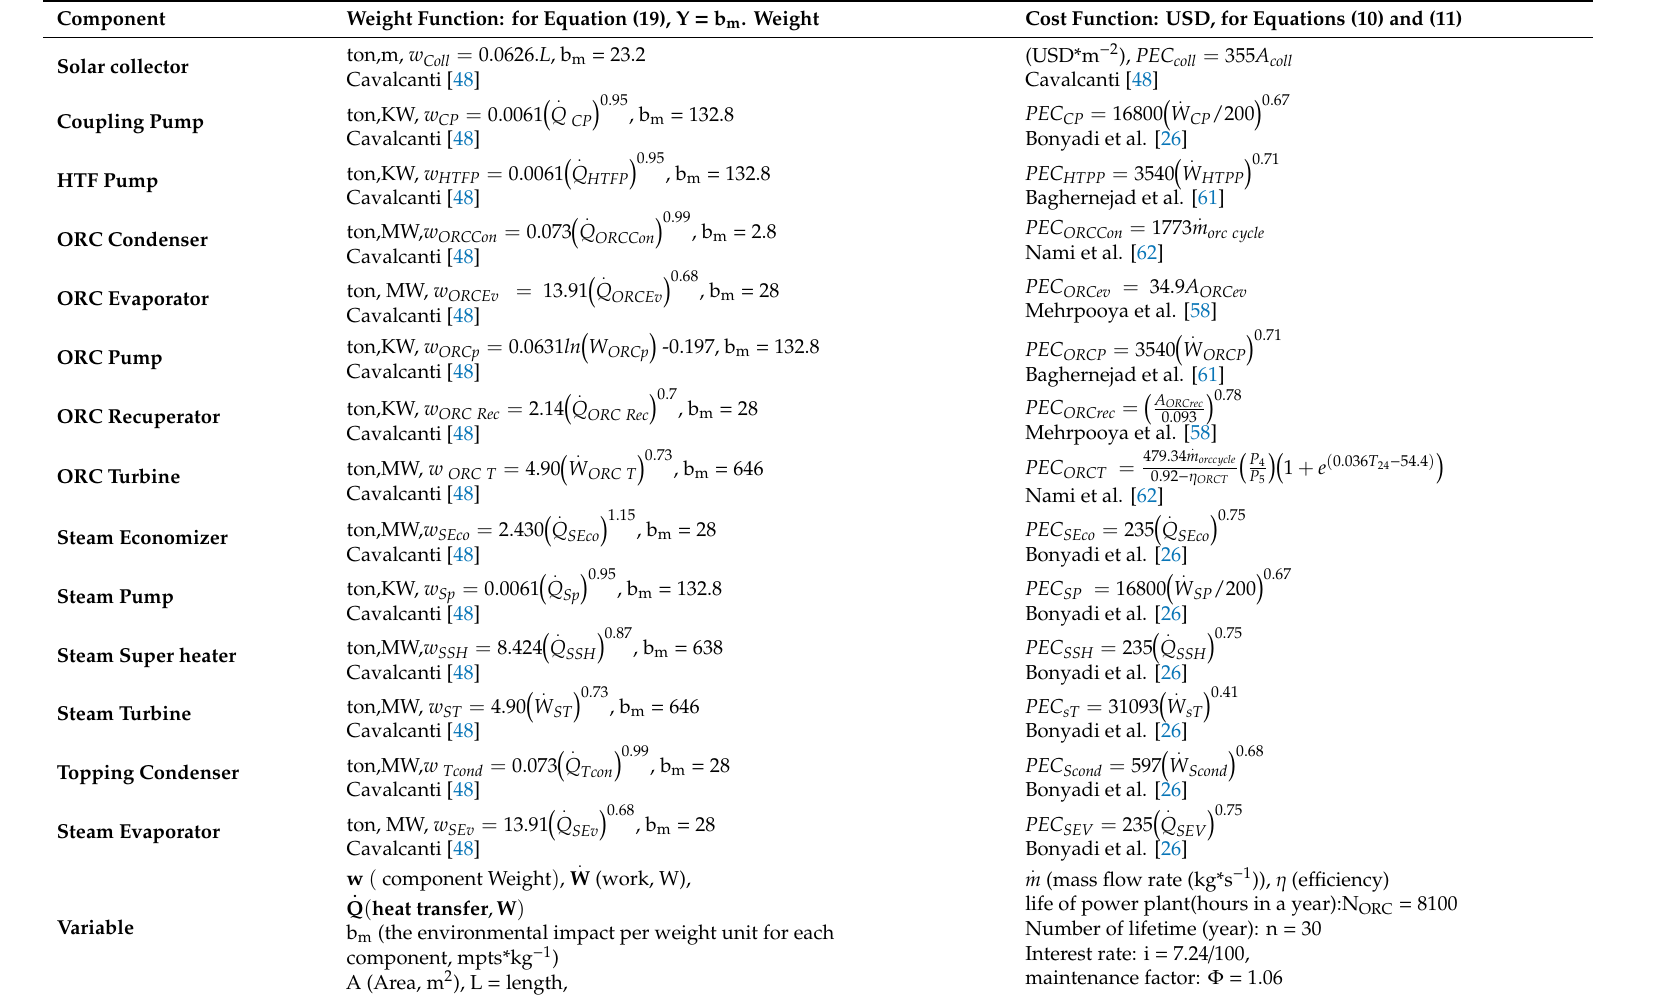
Table A2. Correlation of cost and weight function for